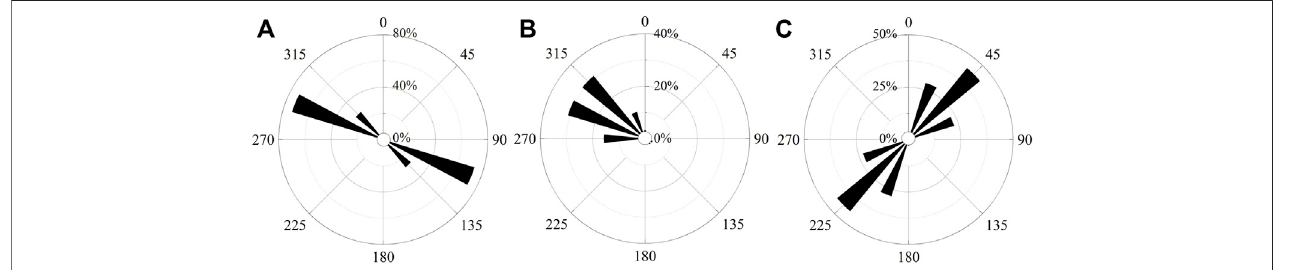
FIGURE 13 | Probability distributions for the orientation of the (A) linear dunes, (B) sand-driving wind, and (C) barchans.